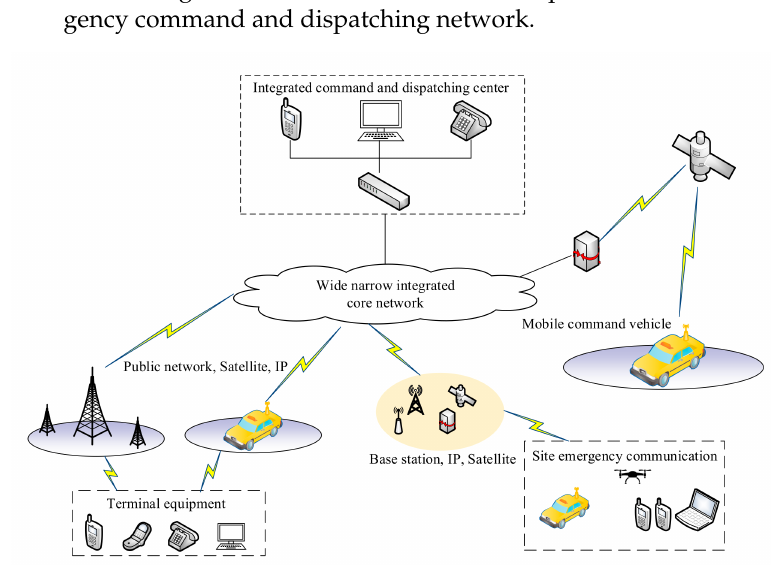
Figure 8. Network structure of 370M narrowband private